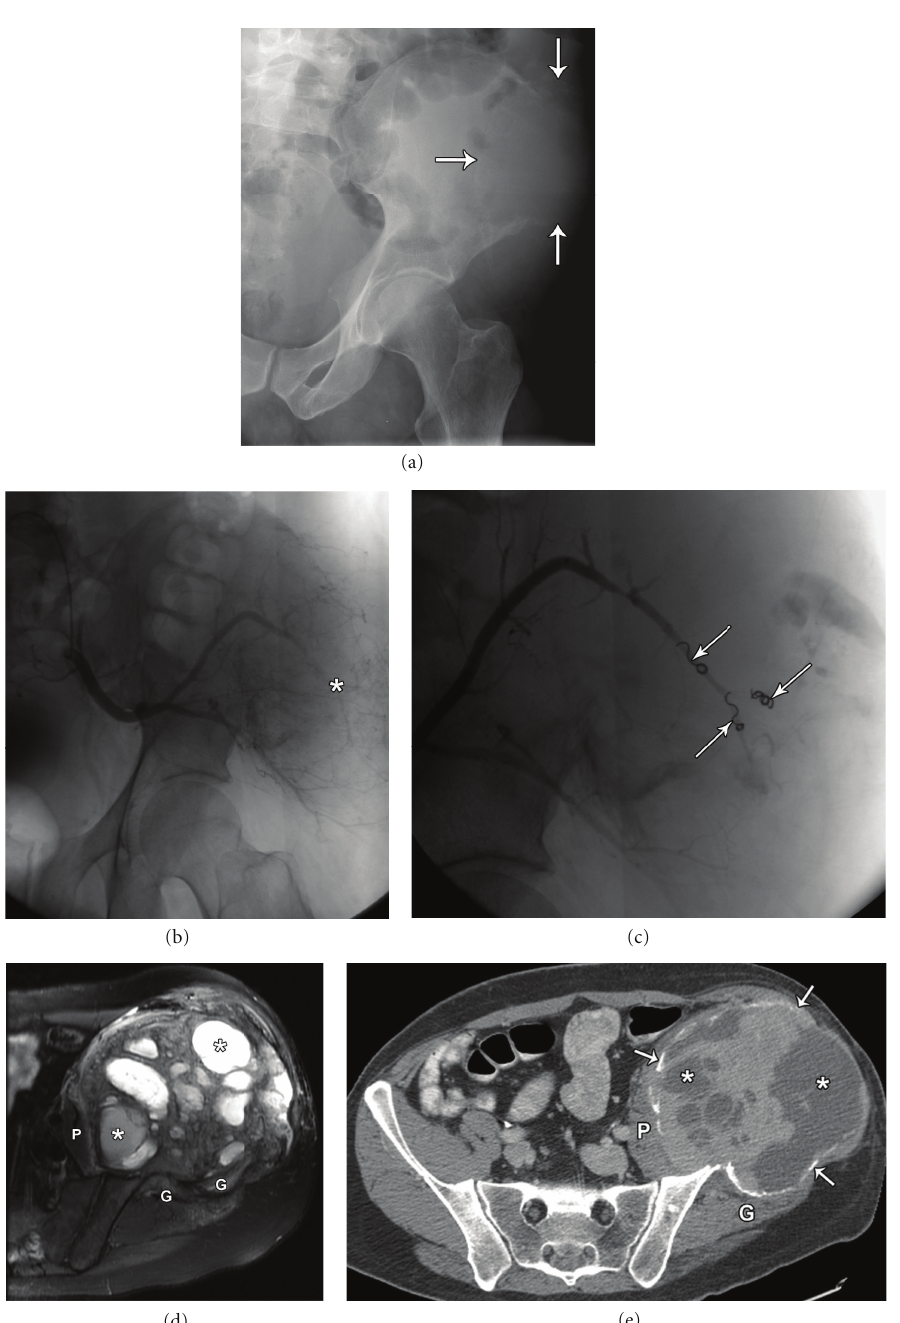
Figure 4: 40-year-old male with a large left iliac wing expansile mass diagnosed as pelvic giant cell tumor. Plain film (a) shows a large, lytic, destructive lesion in the right iliac wing with indistinct margins and cortical breakthrough (arrows), with no visible matrix. Left internal iliac artery angiogram (b) demonstrating the highly vascular nature of the tumor. Selective embolization of the superior gluteal artery (c) demonstrating embolization coils (arrowheads), and decreased tumor vascularity. Axial T2 fat sat MRI (d) and axial post-contrast CT images (e) demonstrating expansile nature of the giant cell tumor with multiple foci of necrosis (asterisk) and intervening tumor stroma. Size of the mass increased following embolization due to internal bleeding and necrosis. Displacement of surrounding soft tissues (Iliopsoas (P), gluteal musculature (G)), rather than invasion is illustrated. Note residual outer rim of expansile cortical bone (arrows), better appreciated on the CT